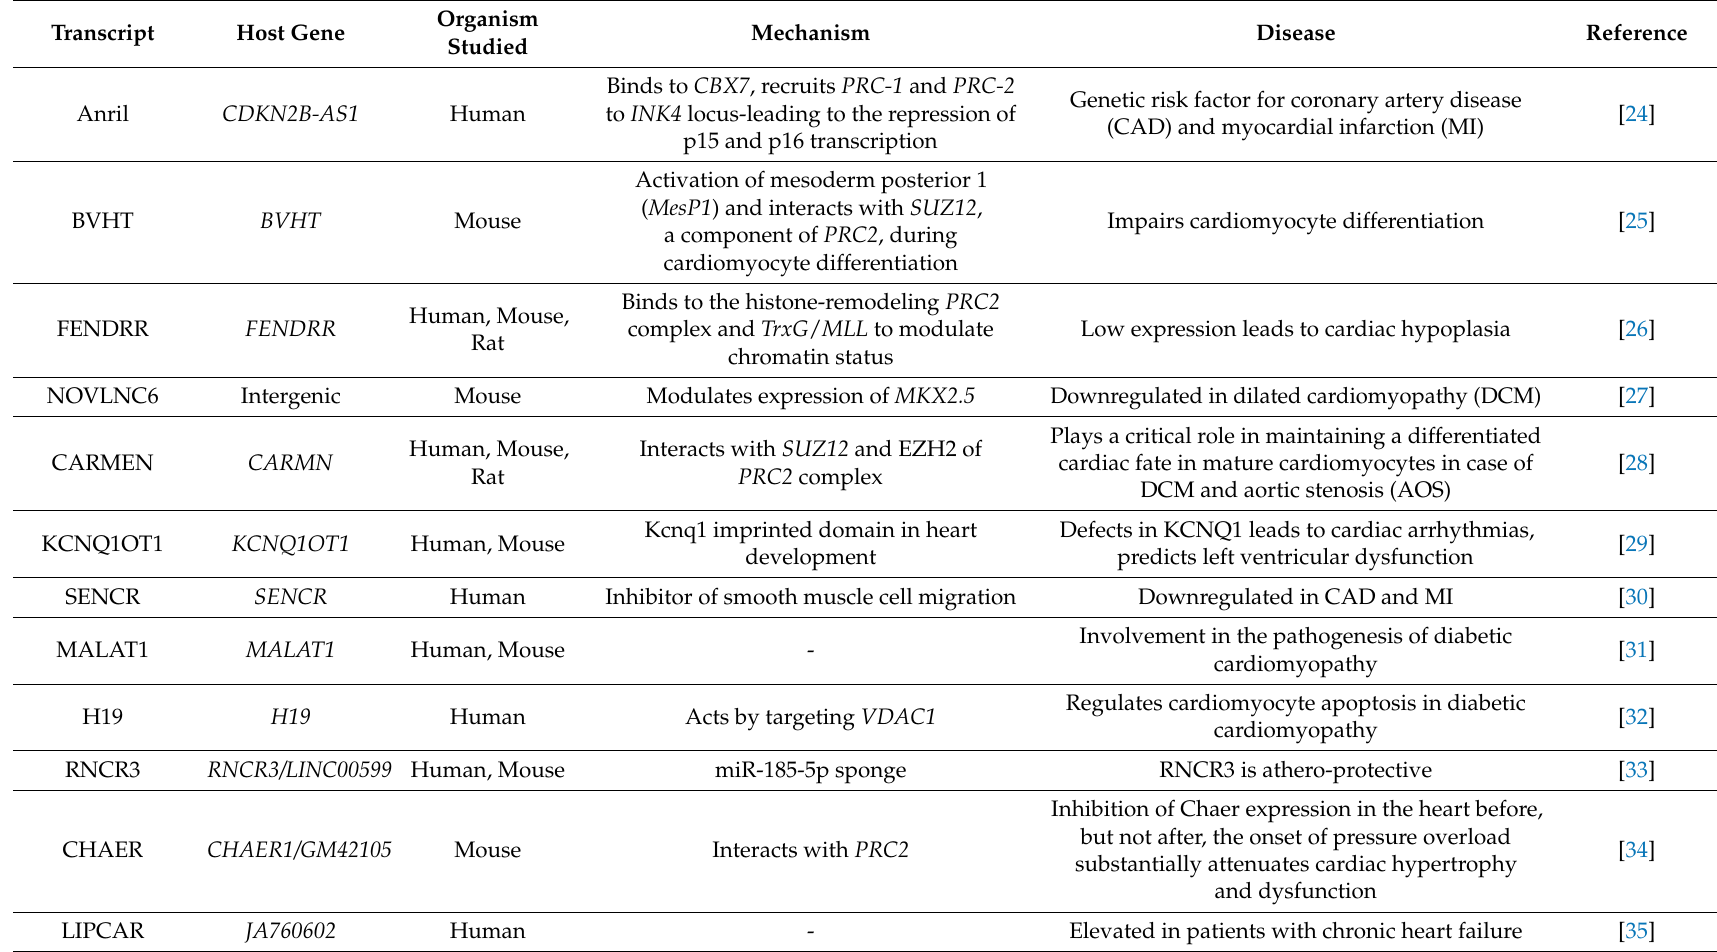
Table 1. List of clinically relevant long non-coding RNAs (lncRNA) in cardiovascular